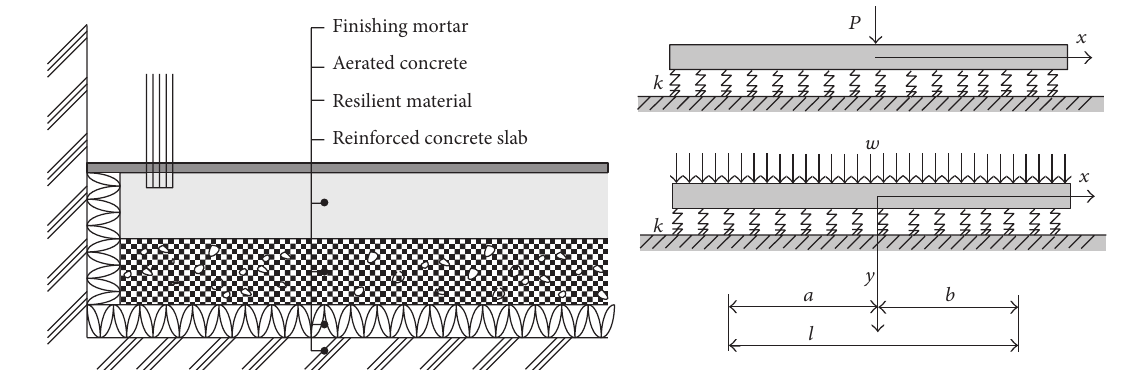
Figure 6: Model of floor sound insulation